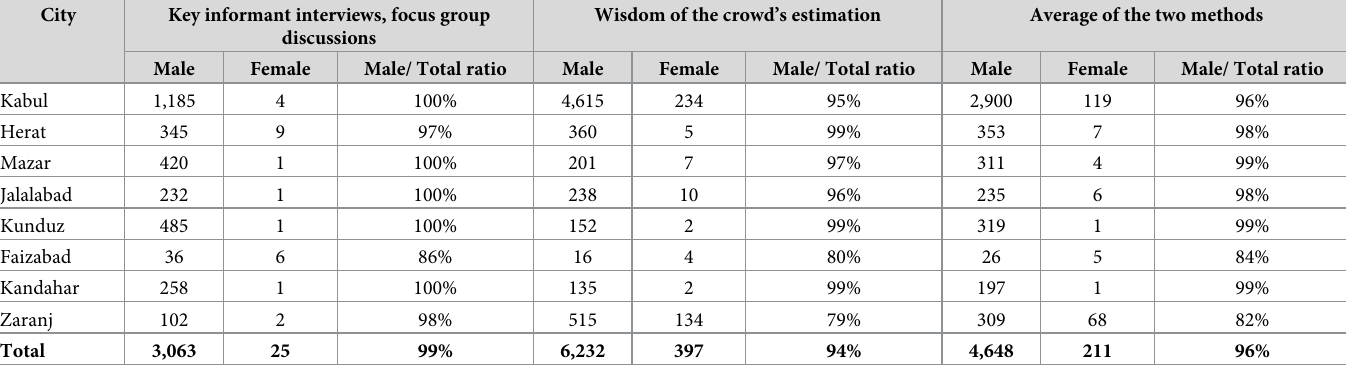
Table 6. Number of men and women who inject drugs and male to total ratio estimated by key informants and wisdom of the crowds methods, by city, Afghanistan, 2019.